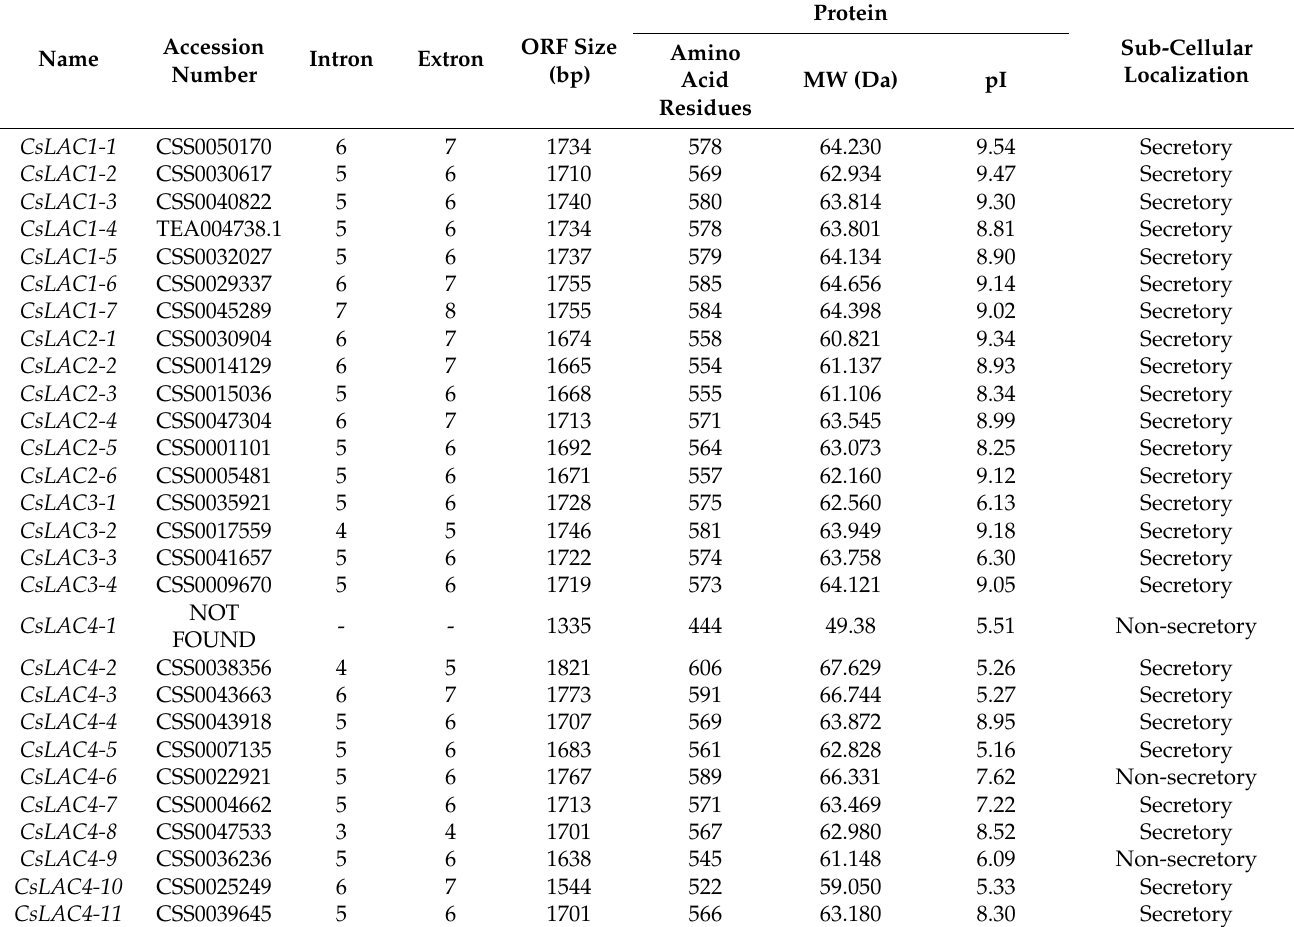
Figure 3. Phylogenetic tree of CsLAC s as well as protein conserved domain and gene structure of corresponding CsLAC s. ( A ) Phylogenetic tree of CsLAC s, as shown in Figure 1. ( B ) Conserved protein motifs and their distribution. The boxes with different colors represent the conserved motifs. ( C ) Exon-intron structure. The CDS, UTR (untranslated region) and introns are represented by yellow boxes, green boxes and gray lines, respectively. Table 1. Identification and analyses of CsLAC